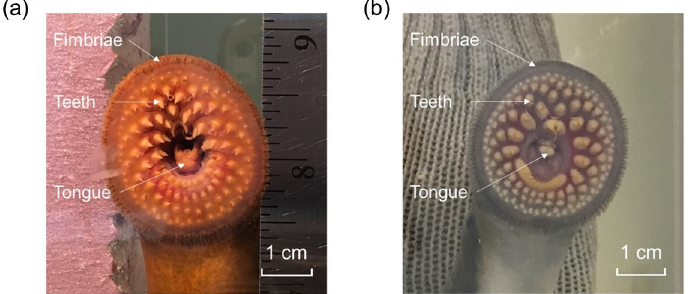
Fig 4. Pictures of the suctorial mouths of the adult and juvenile sea lampreys. (a) Suctorial mouths of an adult sea lamprey, and (b) a juvenile sea lamprey showing that the two are morphologically similar.